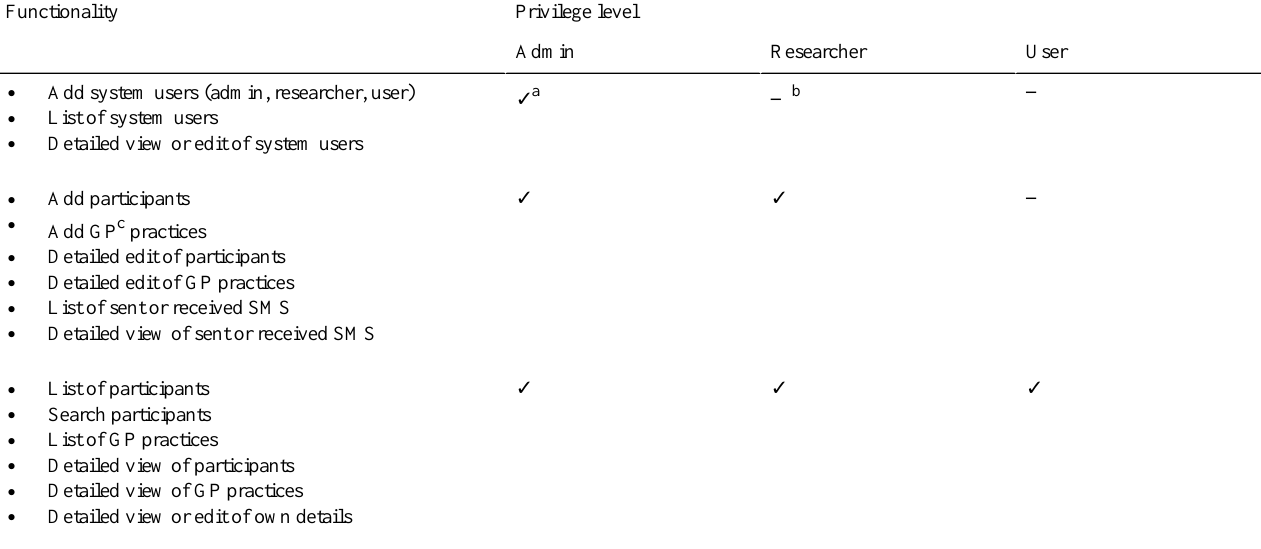
Table 3. Privilege levels and the corresponding functionality available at each of these privilege levels.